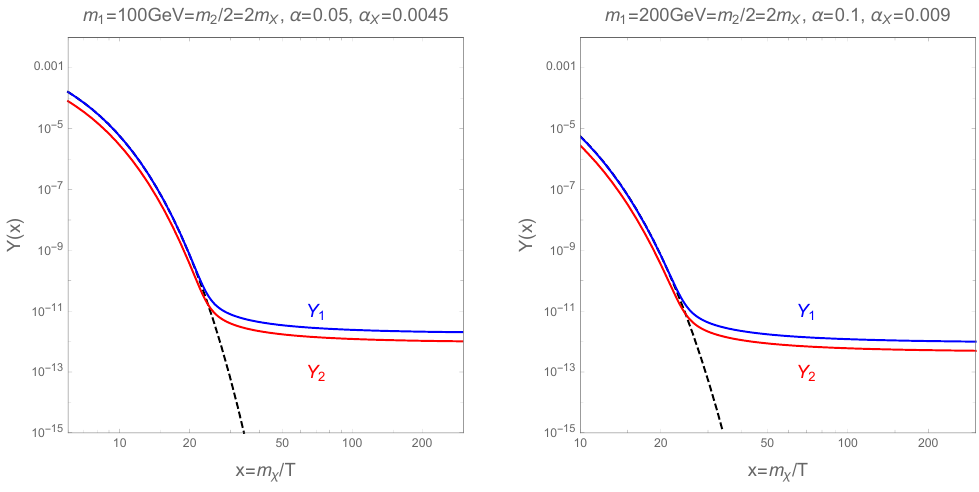
Figure 6 . The relic abundances for two-component dark matter for φ 1 and φ 2 , assisted with dark gauge boson X , shown in blue and red lines, respectively. We took m 1 = m 2 / 2 = 100 GeV = 2 m X / (4 π ) = 0 . 0045 , on left (B1), and m 1 = m 2 / 2 = 200 GeV = 2 m X and α = g 2 / (4 π ) = 0 . 05 , α X = g 2 X and α = 0 . 1 , α X = 0 . 009 , on right (B2). The dashed line corresponds to the case for the equilibrium of φ 1